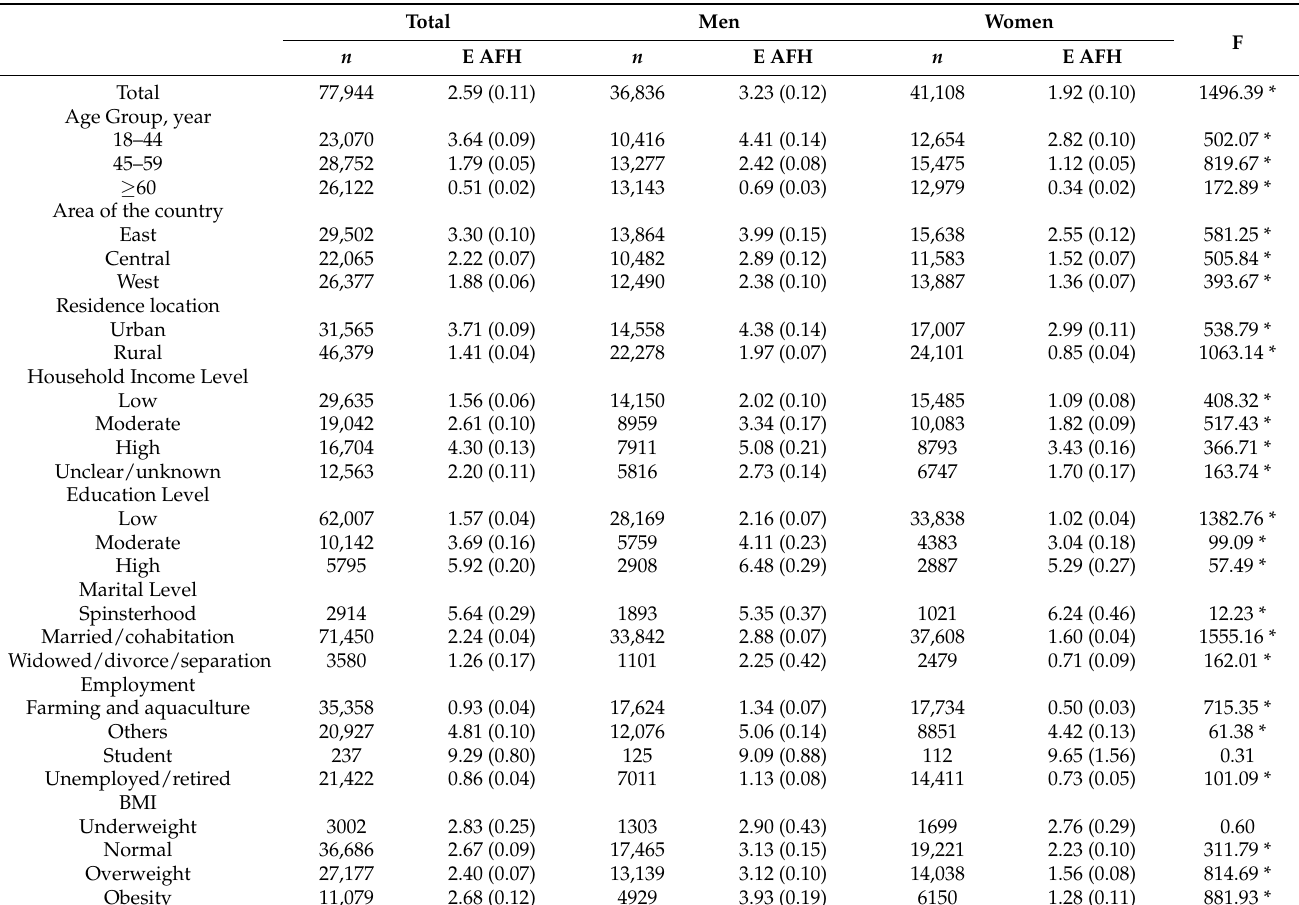
Table 1. Frequencies of EAFH of different gender